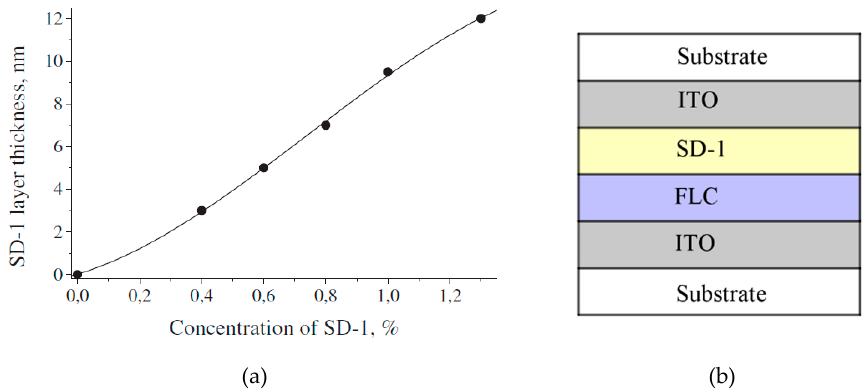
Figure 1. ( a ) Dependence of SD-1 layer thickness versus the SD-1 solution concentration in N,N-dimethylformamide (DMF) spin-coated on the ITO surface at 3500 rpm; ( b ) schematic representation of the ferroelectric liquid crystal (FLC) cell with asymmetric boundaries.